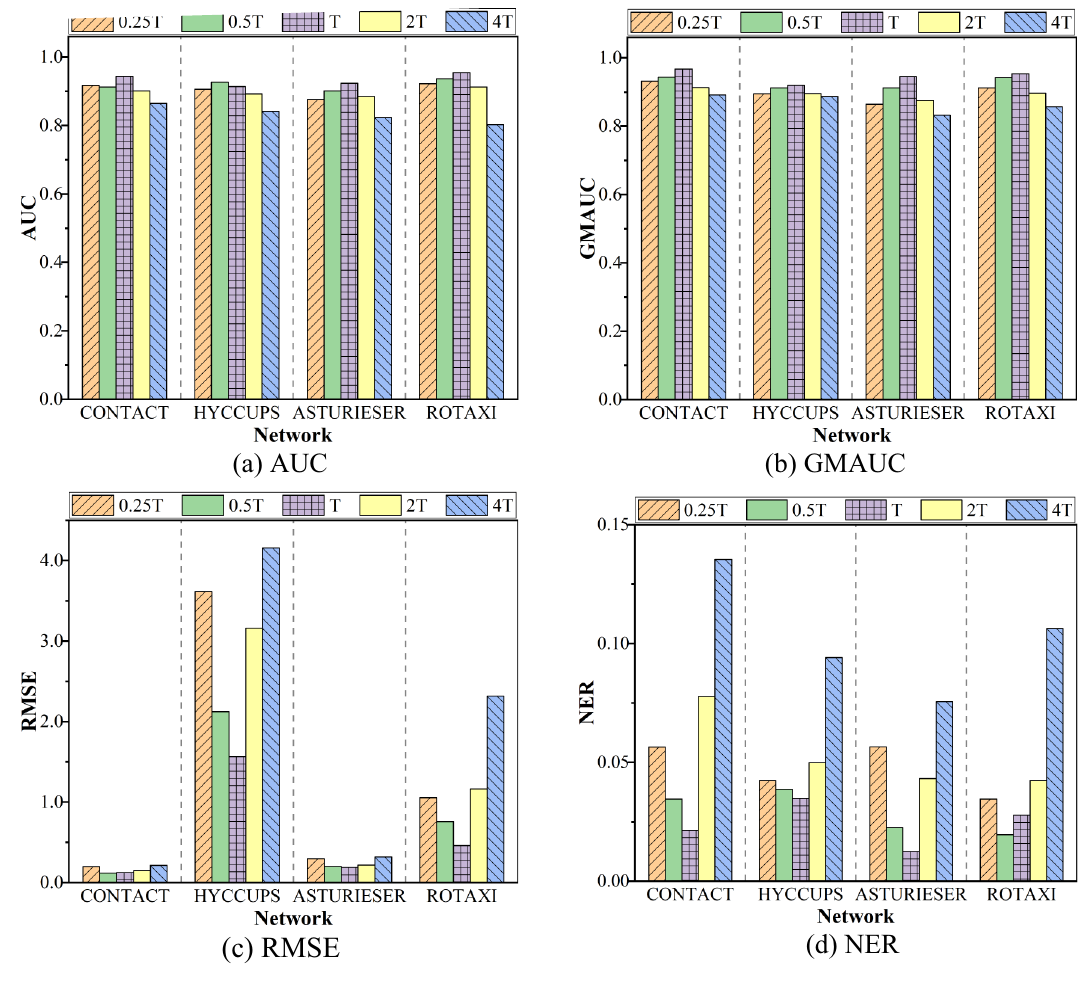
Figure 5. Influence of different slice durations on prediction